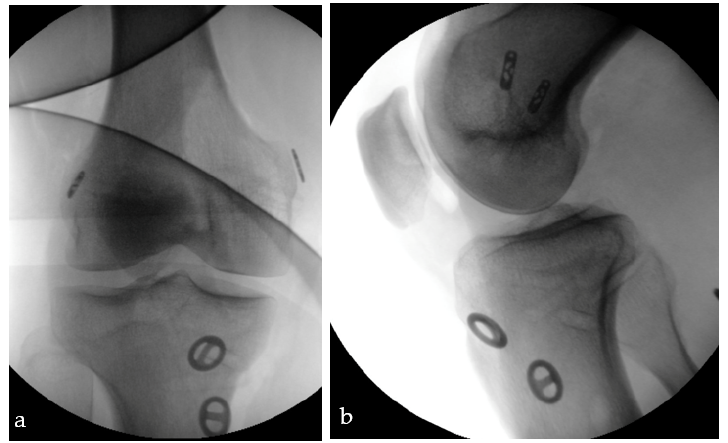
Figure 3. Intraoperative fluoroscopic imaging ( a ) ap-view and ( b ) lateral-view after augmentation of the ACL and PCL with cortical fixed suture tapes.